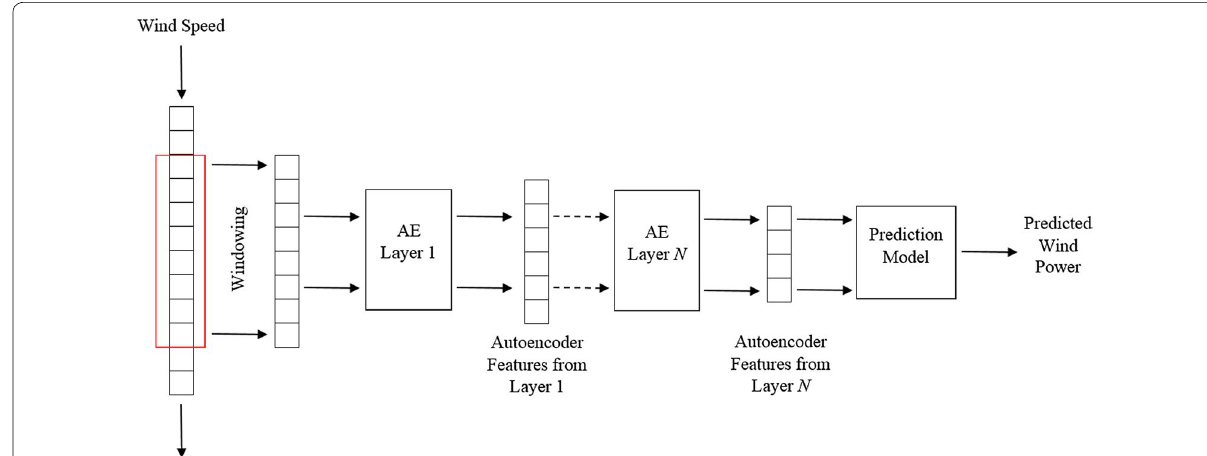
Fig. 1 Stacked autoencoder feature extraction for wind power prediction